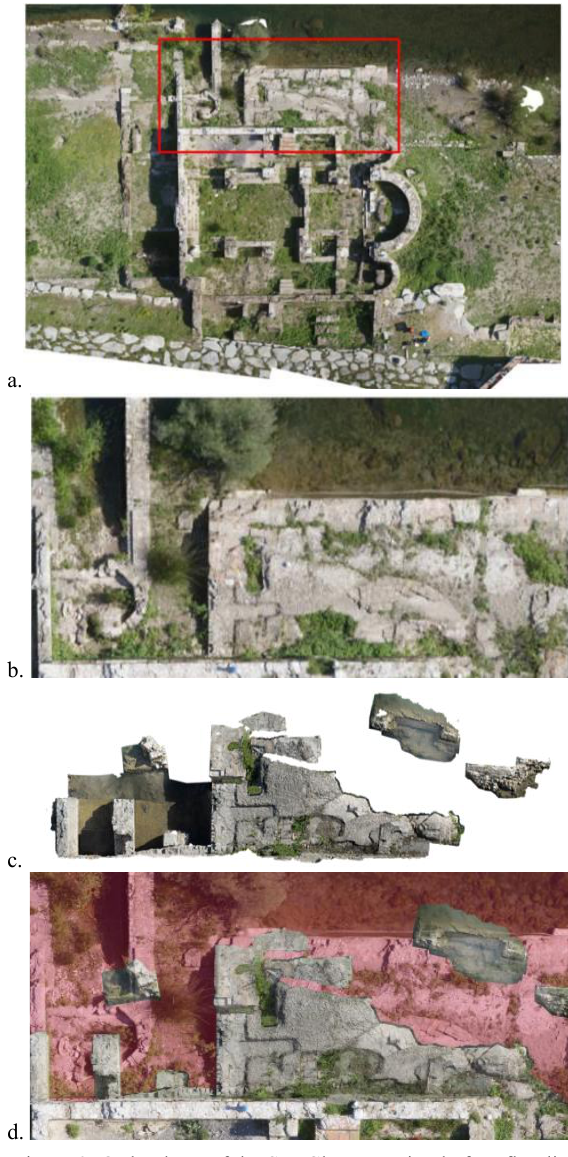
Figure 3. Orthophoto of the San Clemente site: before flooding - Survey Epoch 0 (a); close up of highlighted area that was highly damaged before (b) and after (c) the flooding; overlap of the two earlier orthophotos with epoch 0 in red